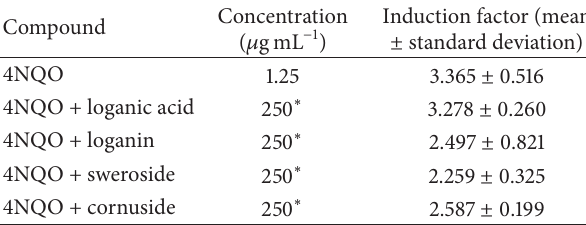
Table 3: Antigenotoxicity test in E. coli